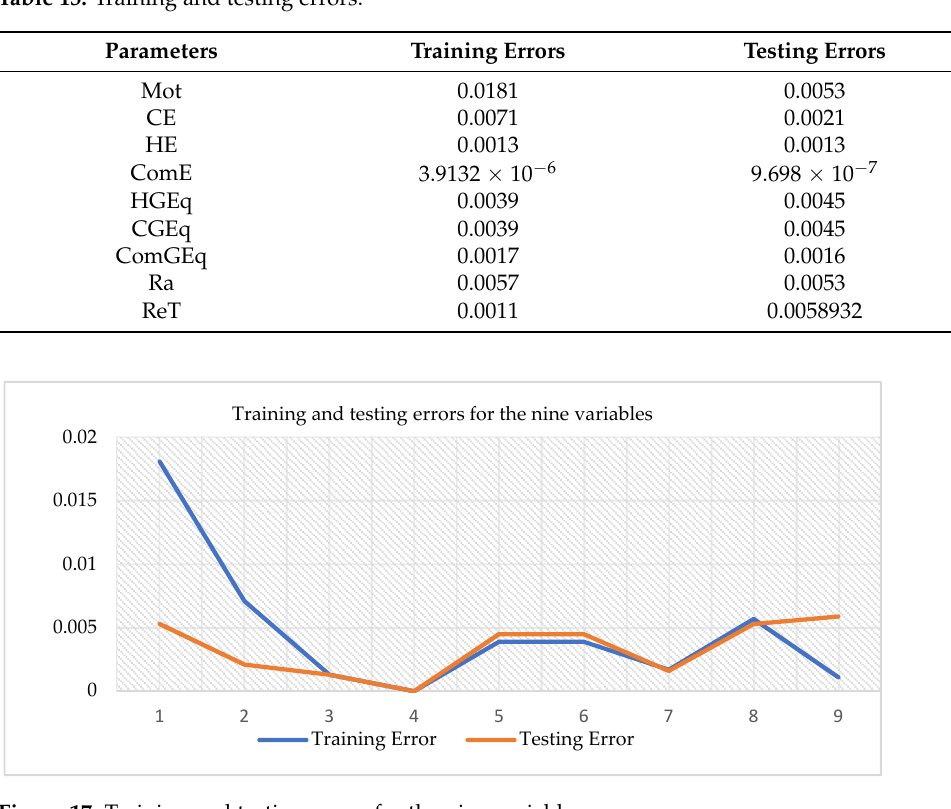
Figure 16. Model evaluation with the redefined parameters.